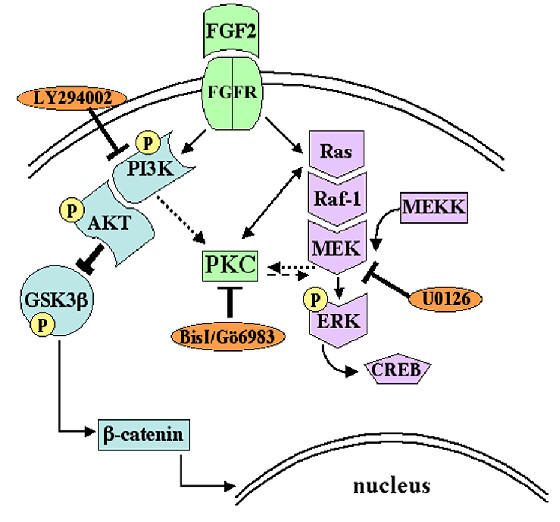
Diagrammatic representation of signalling pathways that may be involved in FGF2-mediated protection from gp120 As indicated by the diagram and as described by the data, it is possible that the crosstalk between the PI3K/AKT/GSK3β and ERK pathways is mediated in part by PKC. PKC signalling also is reported to occur directly with PI3K and upstream of Ras. Furthermore, direct interaction between MEK and PKC downstream of Ras is reported. Likewise, ERK2 (p42) is reported to signal to Raf-1 via a positive feedback mechanism. The points of action of the inhibitors LY290042, U0126, Bisindolymaleimide I, and Gö6983 are also shown.